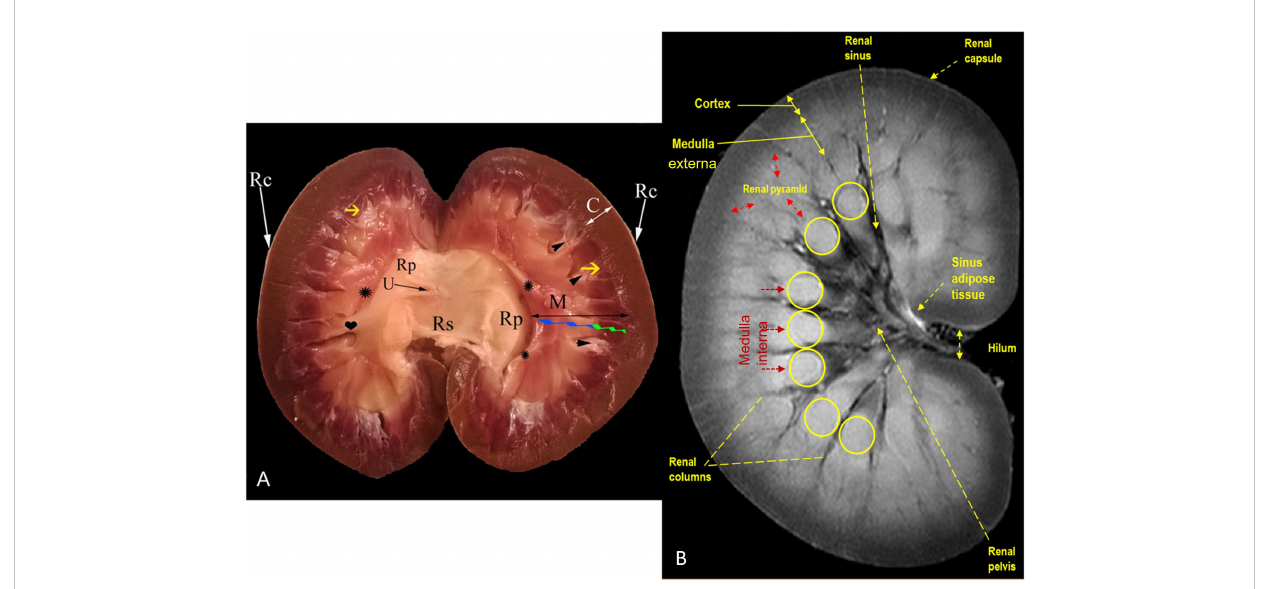
FIGURE 6 Representative mid-longitudinally sectioned gross image (A) and corresponding MR image (B) of the left kidney of dromedaries. Rc, renal capsule; C: cortex; M: medulla; medulla externa (green zigzag line); medulla interna (blue zigzag line); renal pyramid (black double arrowhead); renal crest formed by converging of renal pyramids (asterisk symbols); Rp: renal pelvis; collateral recesses (heart symbol); secondary pyramid (yellow arrow); fornix (arrowhead); U: ureter within fat tissue into the renal sinus; Rs: renal sinus containing fat and